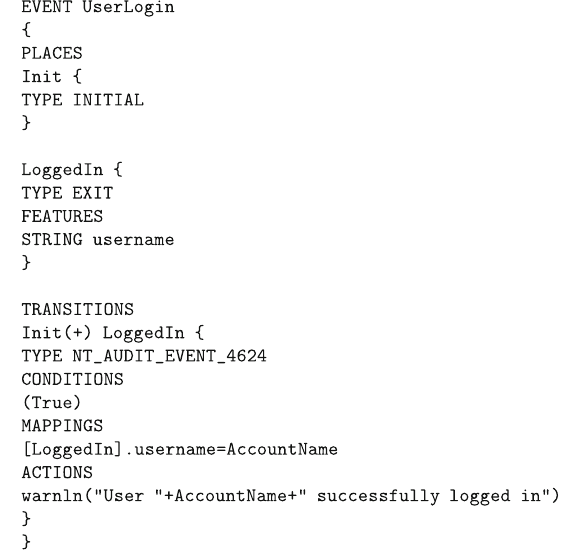
Fig. 16 Example of an EDL signature called UserLogin for a simple login to a Windows system